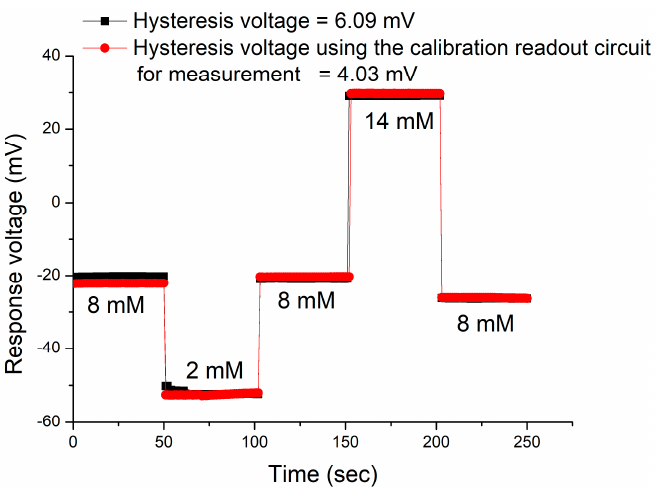
Figure 12. Hysteresis voltages of the CZO sensor by using the V-T measurement system and calibration readout circuit in the forward cycle.